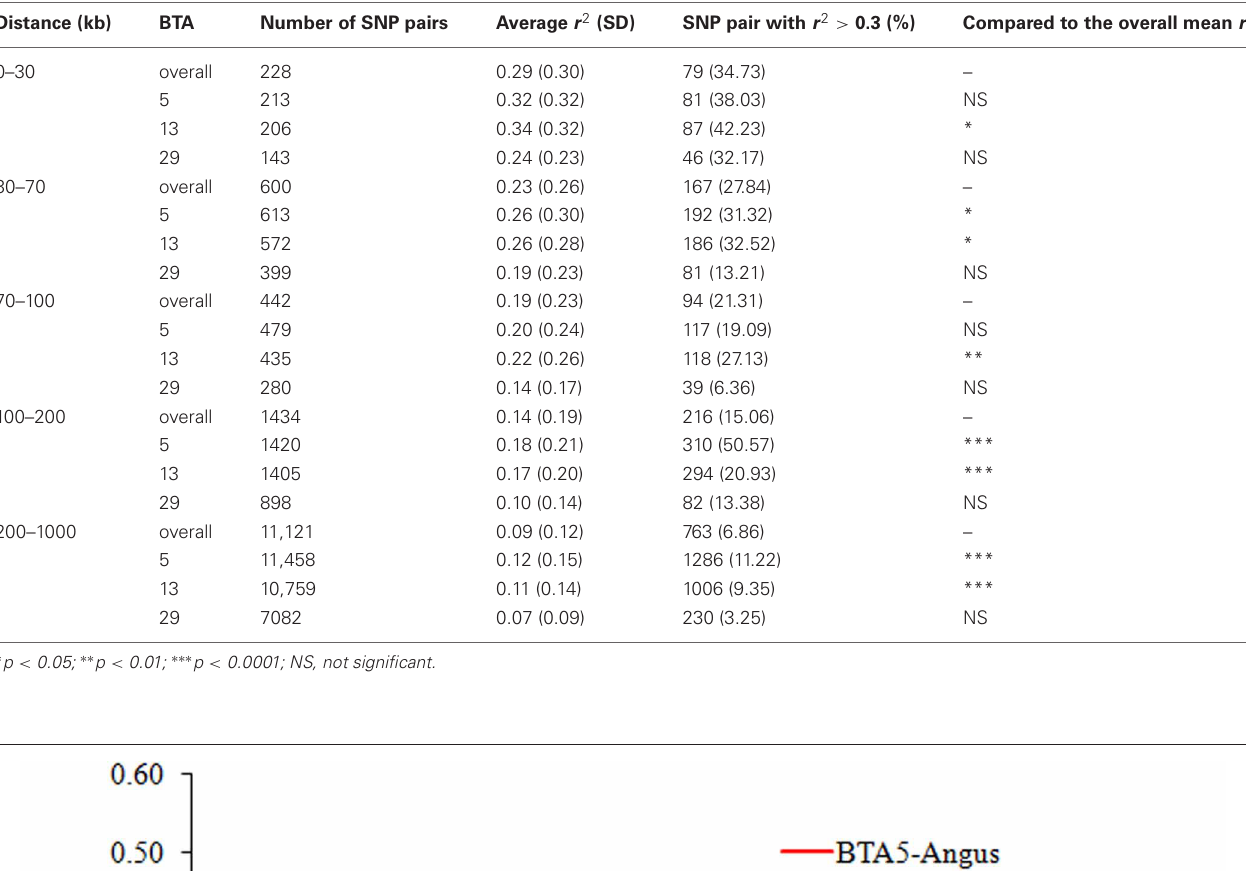
Table 4 | LD observed in Angus on BTA5, 13, and 29.